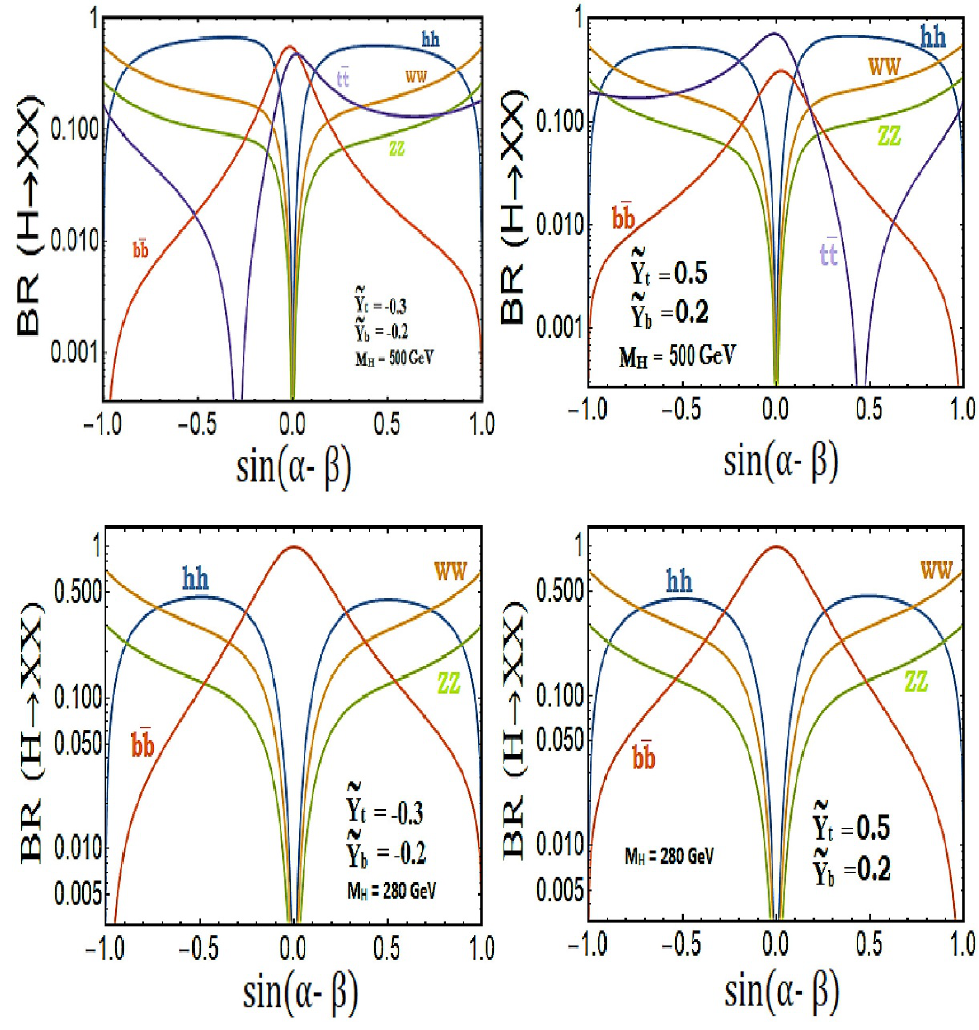
Figure 6 . Branching ratios of H as a function of mixing parameter sin( (cid:11) (cid:0) (cid:12) ).